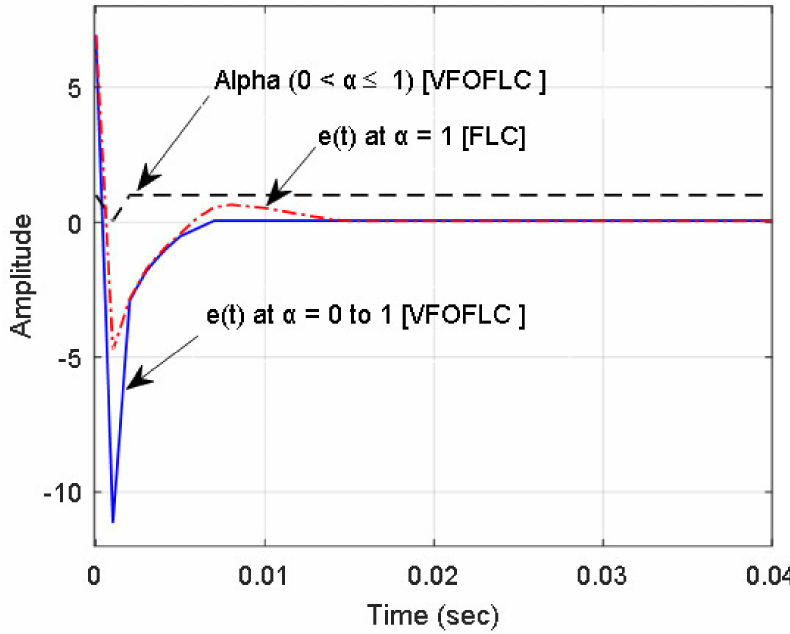
Figure 12. Variation in the domain range of the fuzzy input e(t) based on